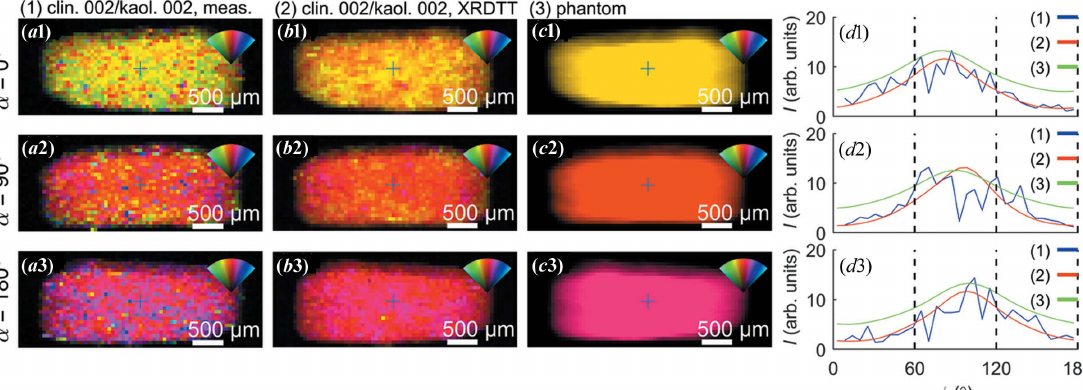
Figure 5 Comparison of the measured directional clay scattering with forward projections of the XRDTTreconstruction and the simple phantom. ( a ) Measured scattering of clinochlore 002 and kaolinite 002 for 0, 90 and 180 (cid:6) . ( b ) Forward-projected scattering from XRDTTreconstruction. ( c ) Forward-projected scattering from the phantom, where all voxels have been assigned the same direction. ( d ) Azimuthal intensity distributions for points marked with (+).